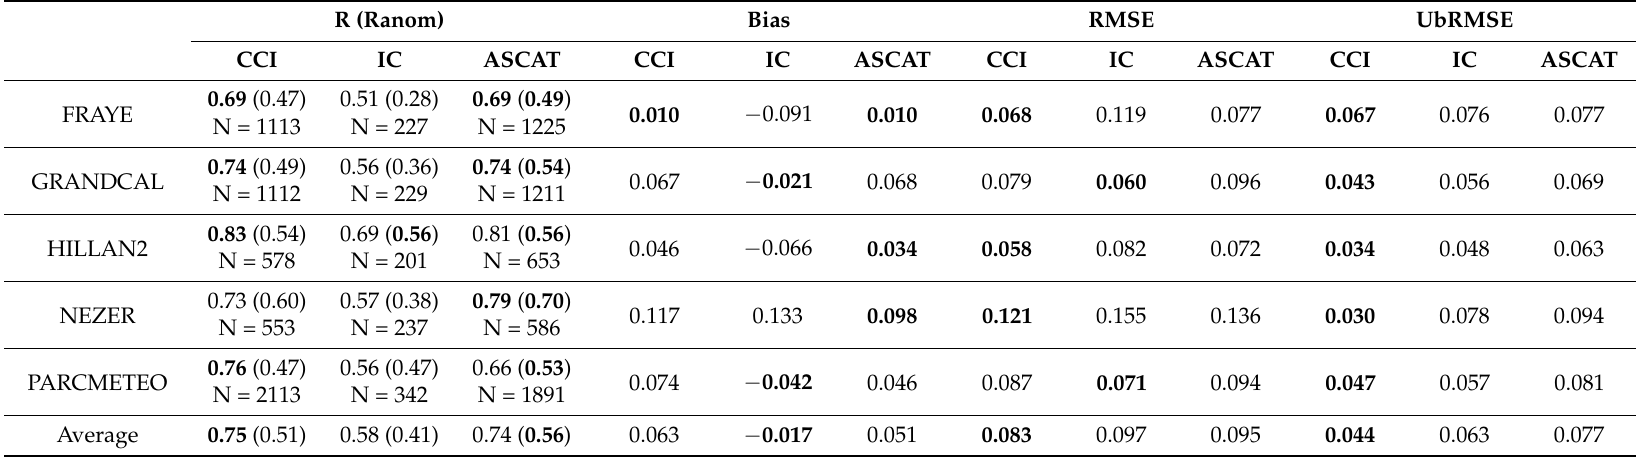
Table 5. Pearson correlation (R), Pearson correlation using anomalies (Ranom), Bias, RMSE, and UbRMSE calculated between SMOS-IC, ASCAT, and CCI SM retrievals and the Bouron in situ measurements using all